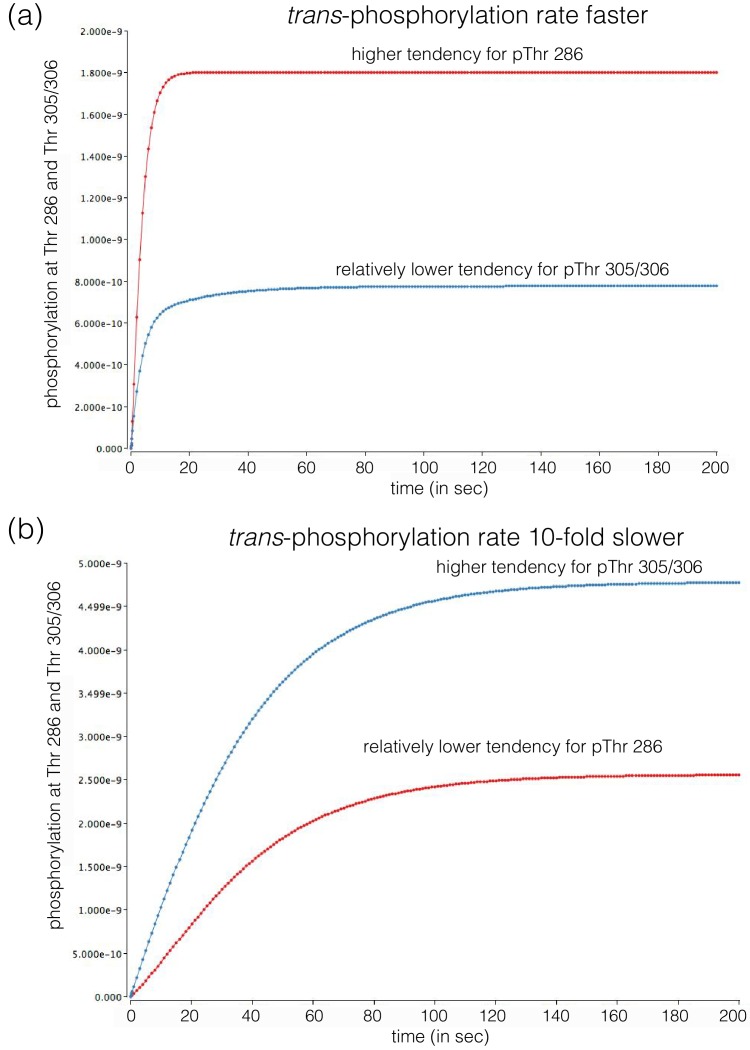
Results from simulations of a simple kinetic model for autophosphorylation in CaMKII using Berkeley Madonna.Plot showing the production of all species bearing pThr 286 or pThr 305/306 over simulation time, when (a) the linker-length is short with faster rates of trans-autophosphorylation and when (b) the linker-length is long and the rates of trans-autophosphorylation are 10-fold slower.